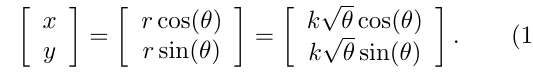
Figure 8: Fermat’s spiral curvature. The asterisk marks the value of θ for which the curve has the maximum